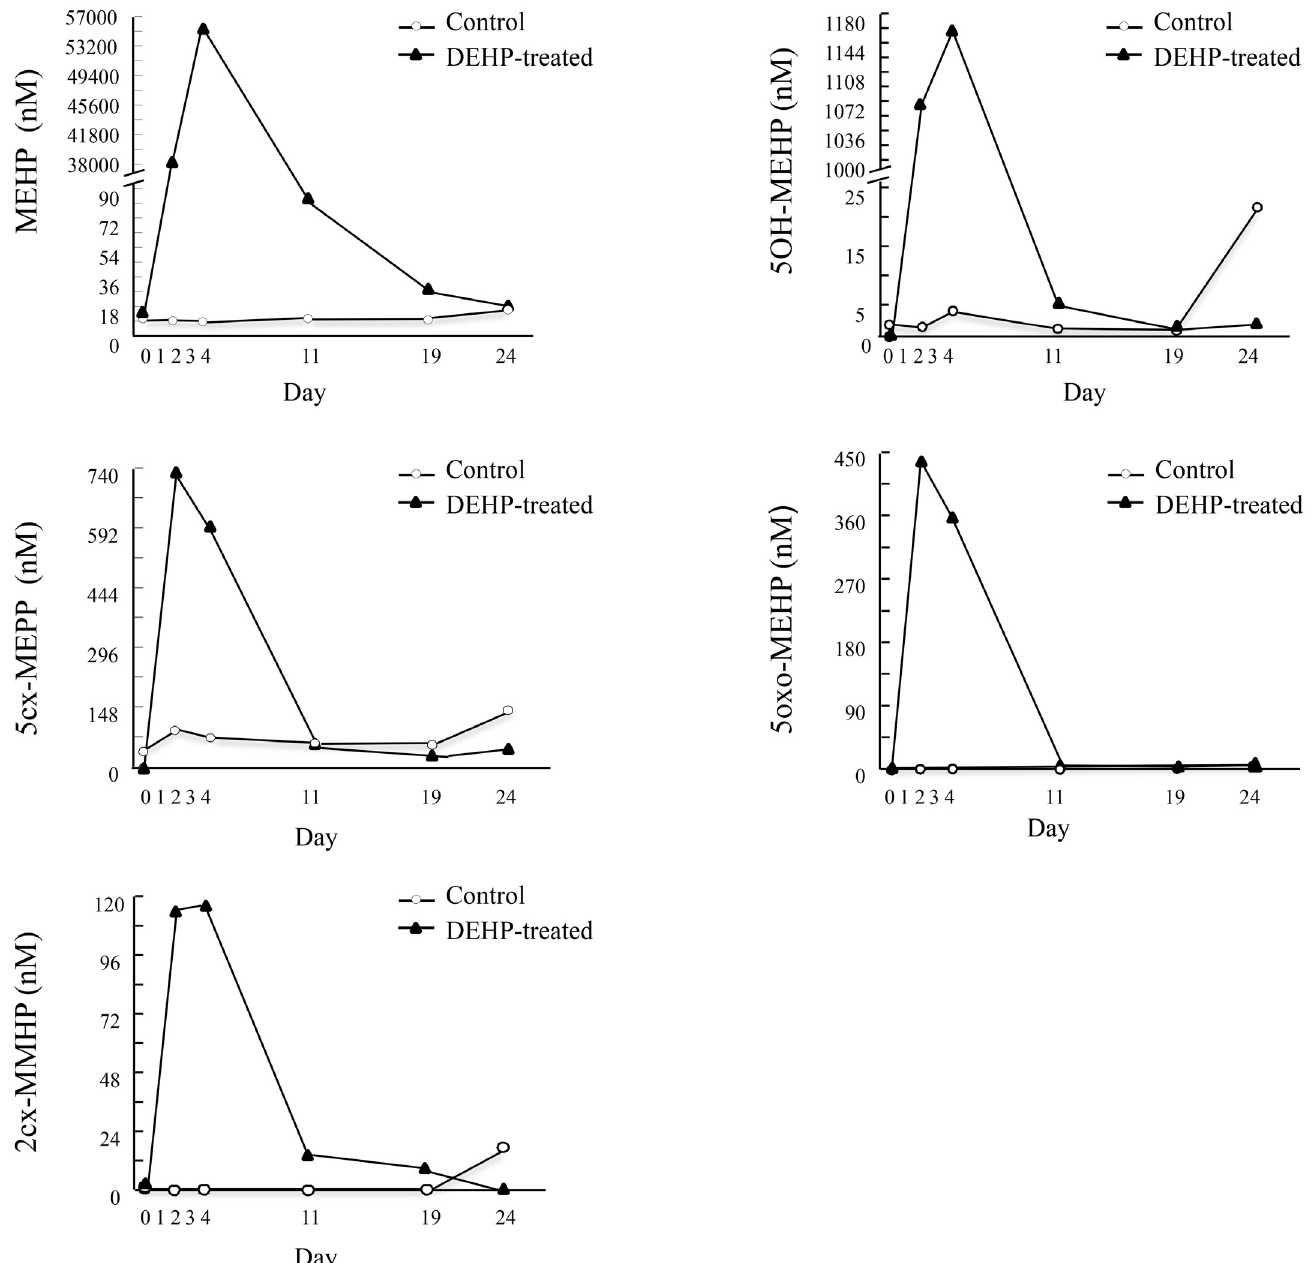
Fig 2. DEHP-metabolite concentrations in the plasma before, during and after DEHP exposure. Cows were administered with water (control) or 100 mg/kg DEHP per day on days 1 – 3 of the experiment (DEHP-treated). Blood samples were taken before (day 0), during (days 2 and 4) and after (days 11, 19 and 24) DEHP exposure. Samples were analyzed for concentrations of DEHP metabolites mono(2-ethylhexyl) phthalate (MEHP), mono(2-ethyl- 5-hydroxyhexyl) phthalate (5OH-MEHP), mono(2-ethyl-5-oxohexyl) phthalate (5oxo-MEHP), mono(2-ethyl-5-carboxypentyl) phthalate (5cx-MEPP) and mono[2-(carboxymethyl)hexyl] phthalate (2cx-MMHP) by LC – MS/MS.